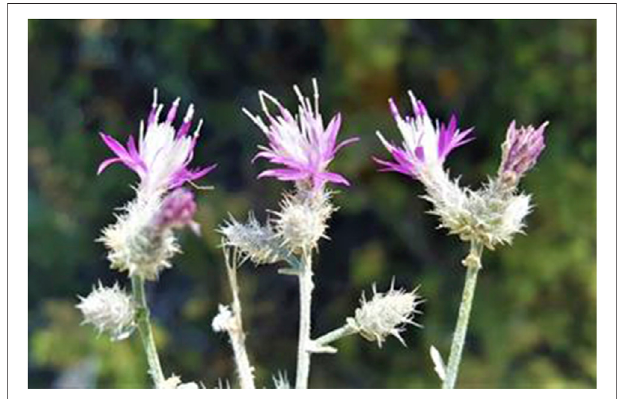
FIGURE 6 | Habit view of endemic Centaurea pinetorum